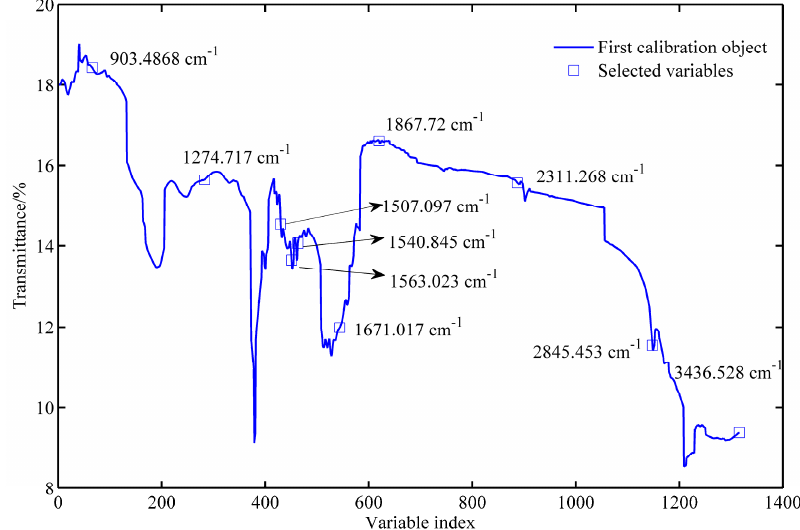
Figure 5. The selected spectral variables after performing UVE-SPA (uninformative variable elimination combining with successive projection algorithm).